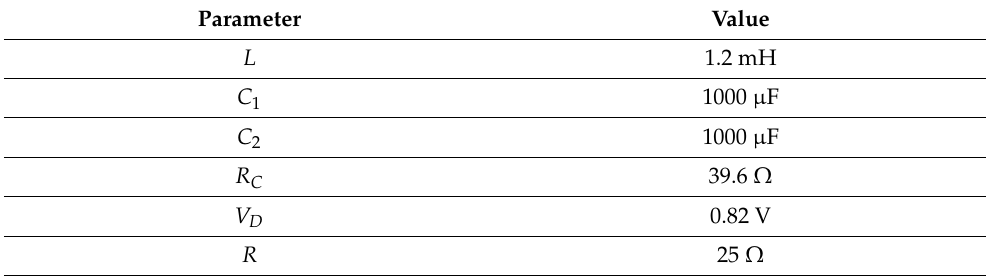
Table 4. DC-DC Boost Converter